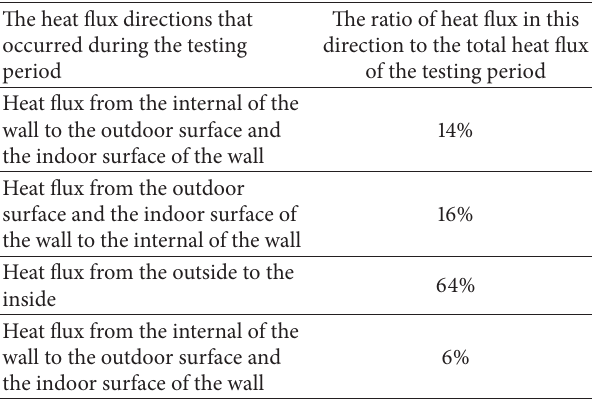
Table 3: The ratio of heat flux in each direction to the total heat flux in the state that air-conditioner runs during the